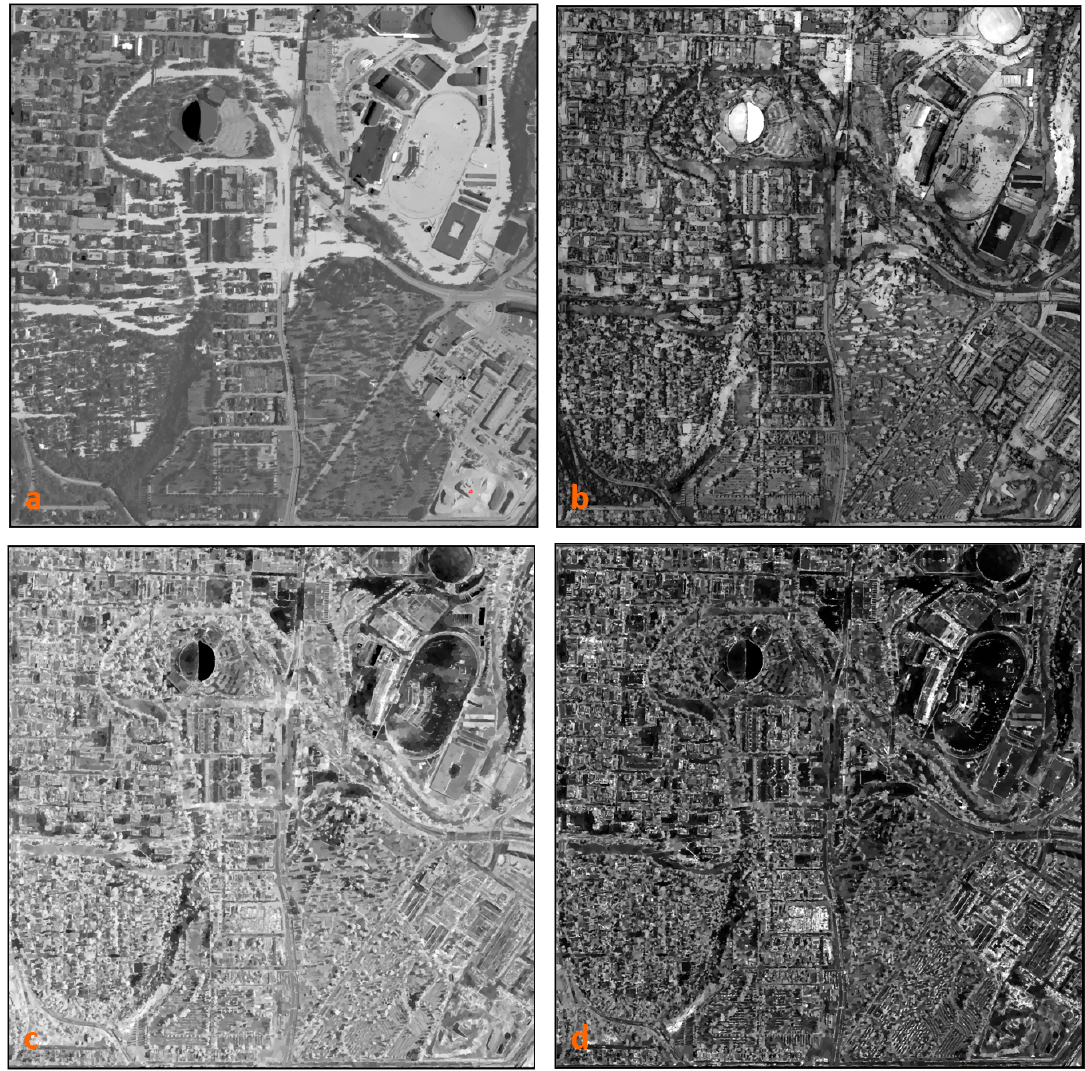
Figure 4. The maps of texture parameters gray-level co-occurrence matrix (GLCM) homogeneity ( b ), GLCM entropy ( c ), and standard deviation of red band ( d ) of test site A. For comparison, the floodwater index (FWI) map of the same test site is shown in ( a ).